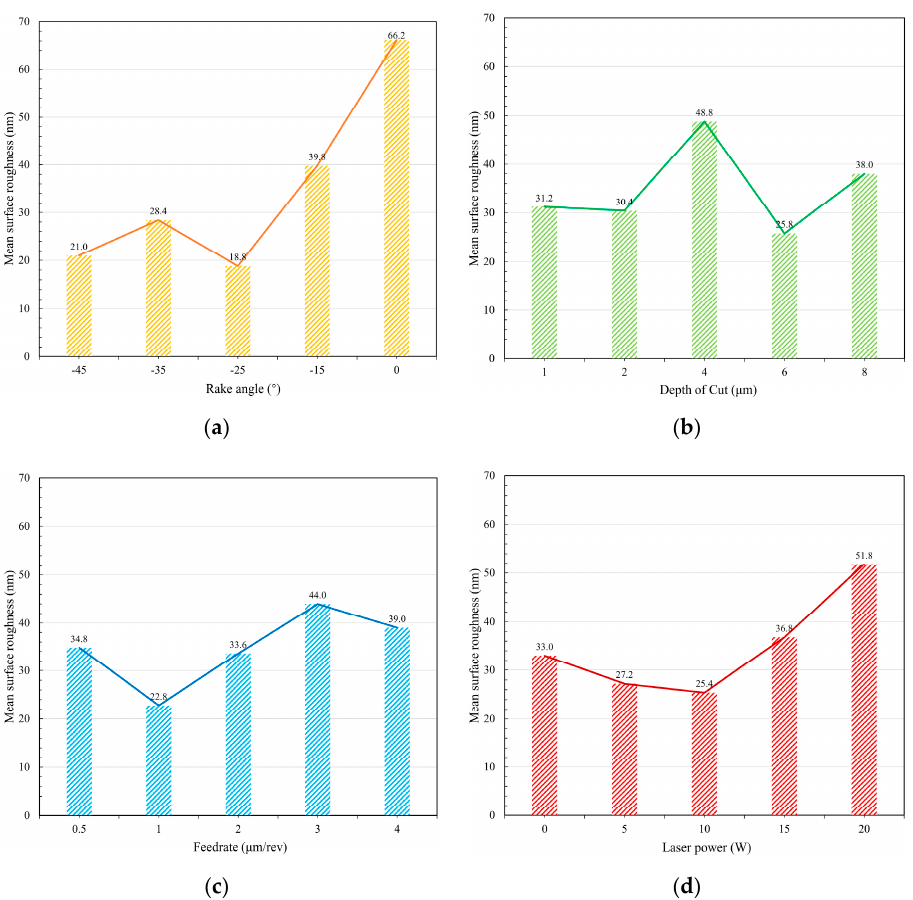
Figure 6. Surface roughness correlation with the variation of ( a ) rake angle, ( b ) DoC, ( c ) feed rate, and ( d ) laser power.